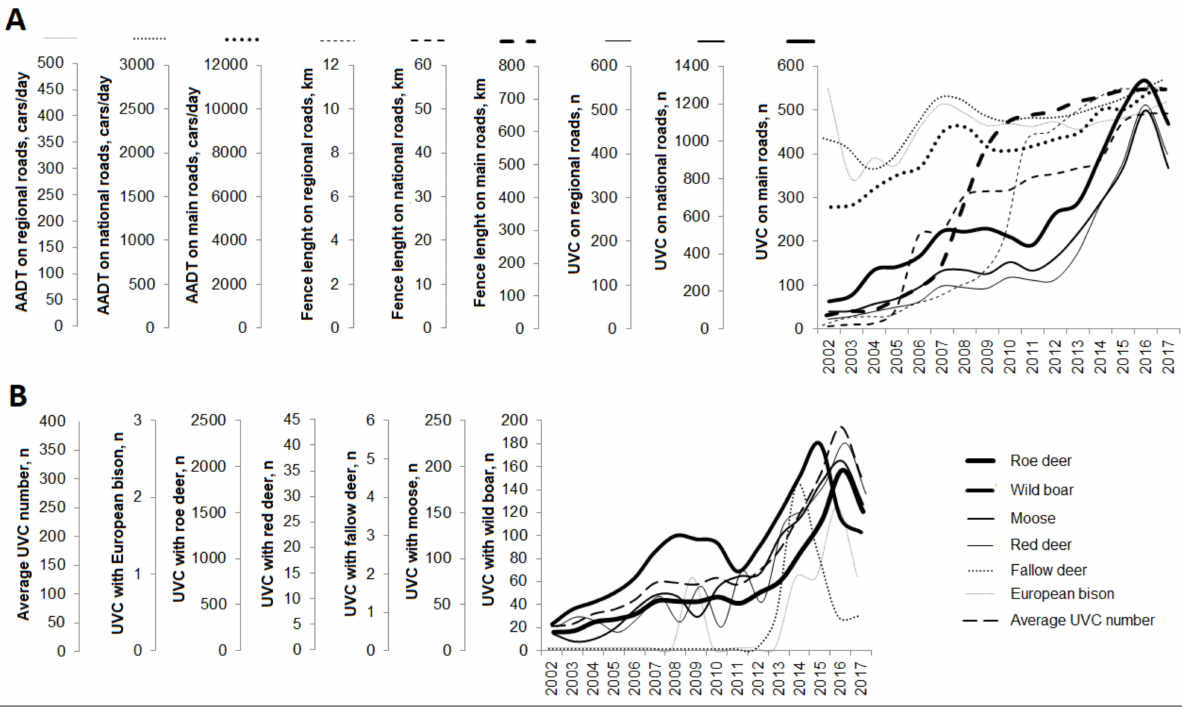
Figure 4. Change patterns of annual average daily traffic (AADT), including all types of vehicles, total UVCs ( A , Table A1), fencing ( A , Table A4), and species-specific UVCs ( B , Table A2) in